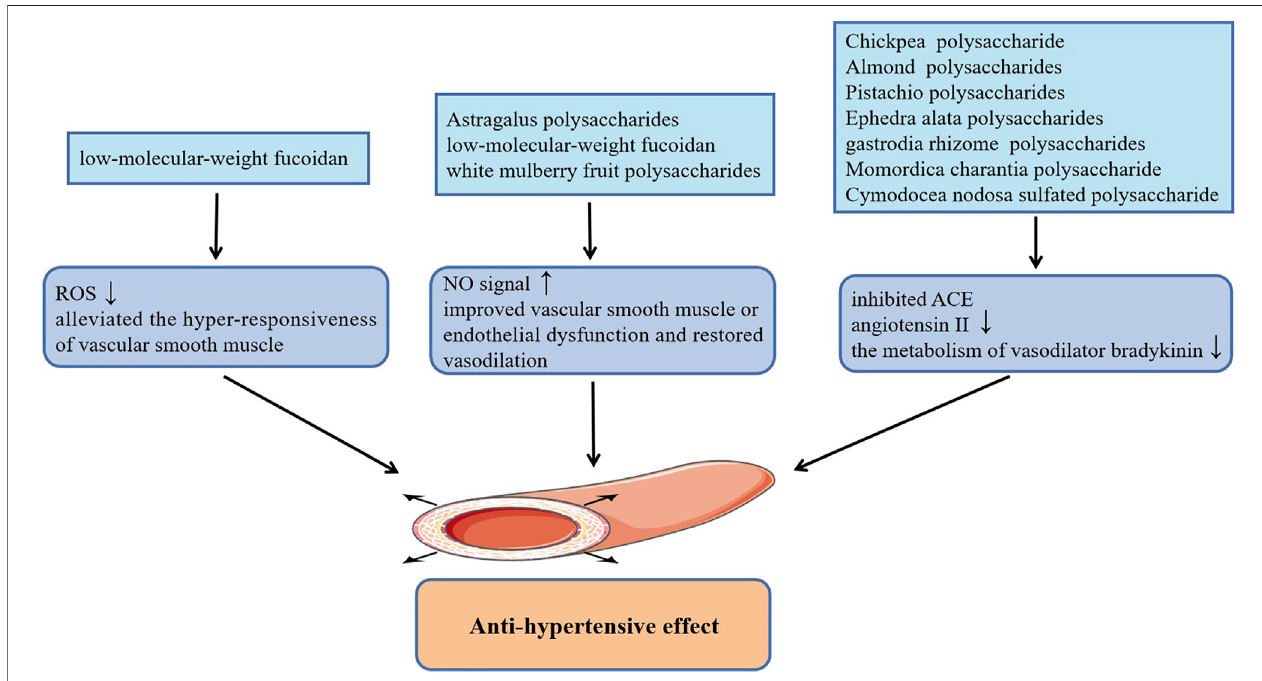
FIGURE 1 | Plant polysaccharides with anti-hypertension